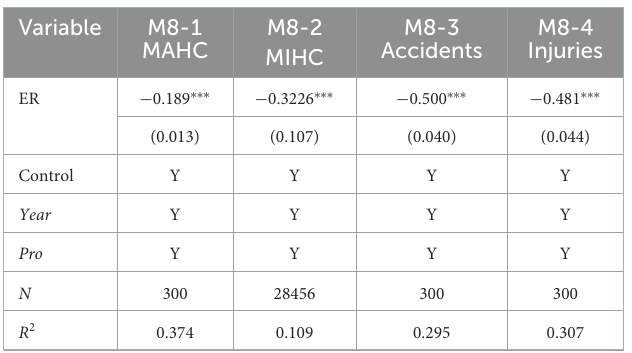
TABLE 8 Test results of cost–benefit